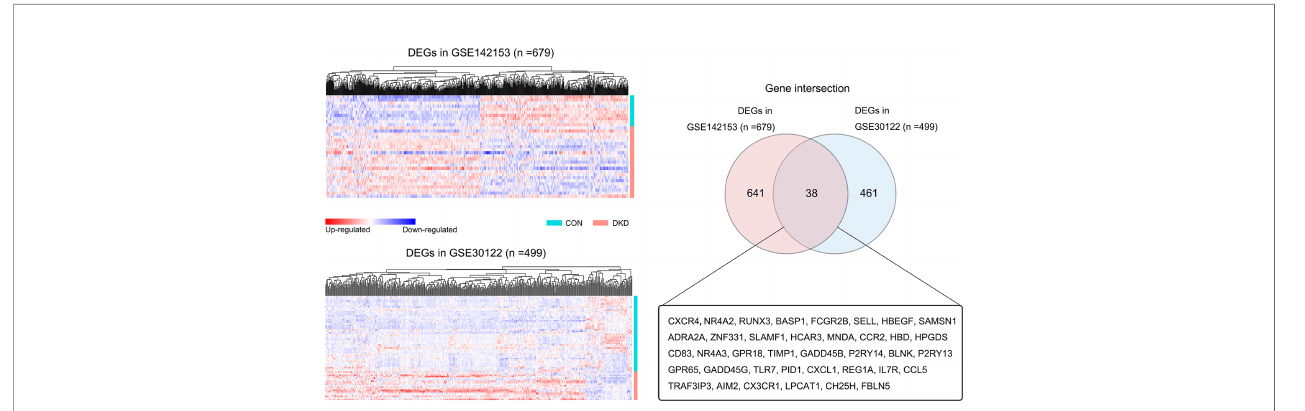
FIGURE 2 | Screening of blood and kidney co-DEGs. Heat map of all DEGs in the blood (GSE142153) and kidney datasets (GSE30122) (DKD vs. HC, p < 0.05). The Venn diagram shows that there are 38 DEGs shared across blood and kidney